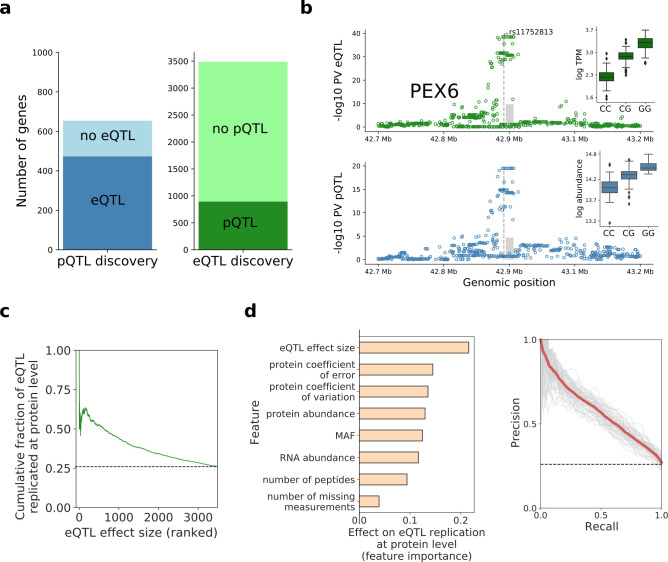
Human iPSC cis protein and RNA QTLs.(a) Number of genes with a protein (blue) or RNA (green) cis QTL (FDR < 10%) and pairwise replication of genetic effects. Left: Number of genes with a pQTL, either with (dark blue) or without (light blue) replicated RNA effect. Right: Number of genes with an eQTL, either with (dark green) or without (light green) replicated protein effect. Replication defined by assessing nominal significance (PV <0.01) of QTL in the respective other layer. (b) Local Manhattan plots displaying negative log p-values (PV) from cis RNA (top) and protein (bottom) QTL mapping for PEX6. The dashed line and the grey box indicate the genomic positions of the lead QTL and of the gene. Boxplots show RNA and protein expression for different alleles at the pQTL lead variant rs11752813, a variant in LD (r2 = 1, 1000 Genomes European populations phase 3) with the Alzheimer risk variant rs1129187 (Jun et al., 2016) (OR 1.13). (c) Cumulative fraction of eQTLs with replicated protein effects as a function of the eQTL effect size (from highest to lowest). (d) Prediction of protein replication of eQTLs, considering features derived from gene annotations, eQTL, RNA and protein data. Predictions were obtained using a random forest model trained on the protein replication status of eQTL (as in a; Materials and methods). Left: Feature importance scores. Right: Precision-recall curve for the model, evaluated in independent test fractions. The model performance was assessed by random sampling of training/testing data with a 80/20 split, performed 50 times. Shown in red is the average precision-recall across all sampled training/test splits and in thin grey lines results of individual folds.Figure 2—source data 1.pQTL_results.The list of significant (FDR < 10%) genes with a pQTL provided as a supplementary file. Data fields are described in the table below.Figure 2—source data 2.eQTL_results.Reported are genes with a significant (FDR < 10%) QTL. It consists of variants mapped at RNA, gene resolution, for genes detected at both RNA and protein levels. This table includes the features used in the prediction of the pQTL status. The table columns are analogous to Figure 2—source data 1 pQTL_results.